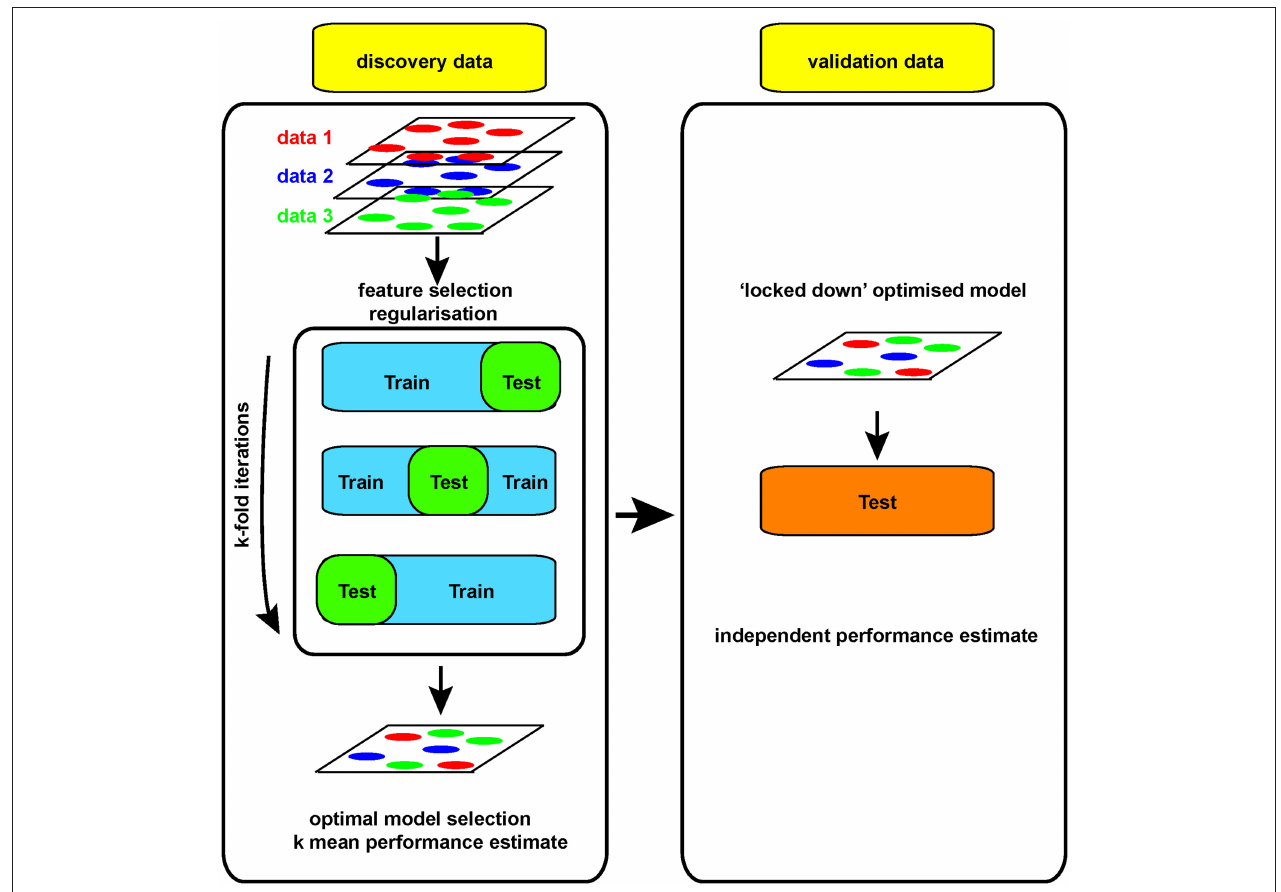
FIGURE 3 | Model performance